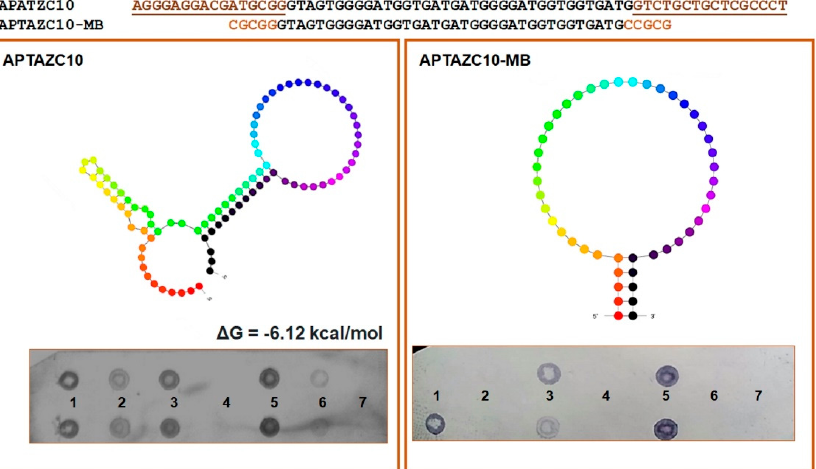
Figure 3. Characterization of the aptamers APTZC10 and APTZC10-MB. The APTZC10-MB was derived from APTZC10 as a molecular beacon, with a well-defined stem and loop structure. The dot-blot results allowed us to evaluate the affinity of both as ligands against: (1)—dsDNA 5’UTR-DENV; (2)—ssDNA 5’UTR-DENV2; (3)—dsDNA 5’UTR-ZIKV; (4)—ssDNA 5’UTR-ZIKV; (5)— dsDNA of the APTZC10 (positive control); (6)—ssDNA of the APTAZC10 (positive control); (7)— PBS buffer (negative control). The APTZC10-MB was more selective for the targets containing more than one strand in their structures.